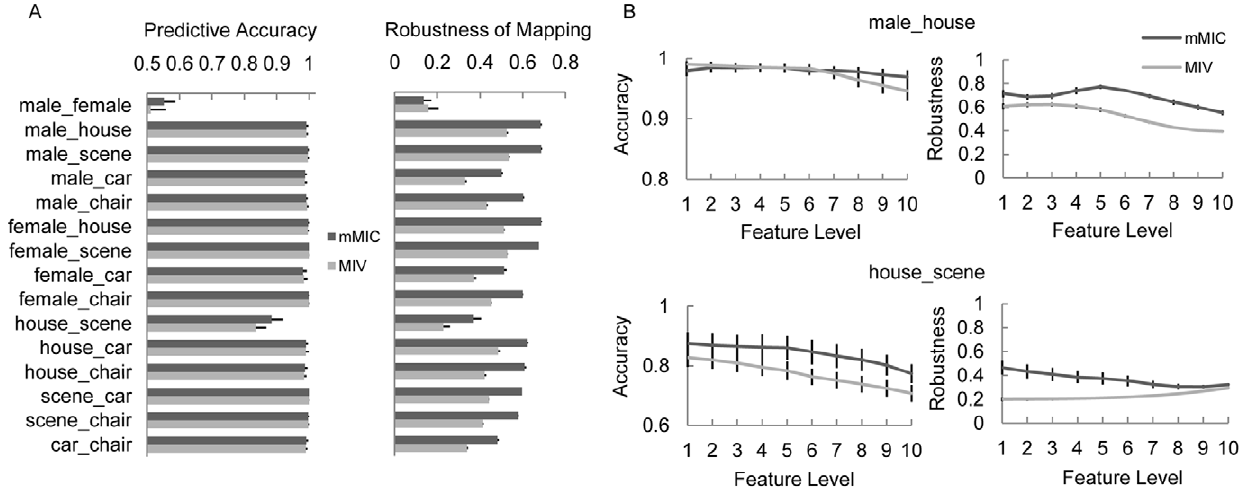
Figure 3. Performance of the mMIC and the MIV in the real fMRI data. A) Predictive accuracy (left) and robustness of mapping (right) for all 15 contrasts. Dark bar: mMIC; light bar: MIV. B) Predictive accuracy and robustness of mapping at 10 feature levels in two representative contrasts (male_house: male faces versus houses; house_scene: houses versus scenes). Error bars indicate standard error of mean across subjects. doi:10.1371/journal.pone.0015065.g003 PLoS ONE |